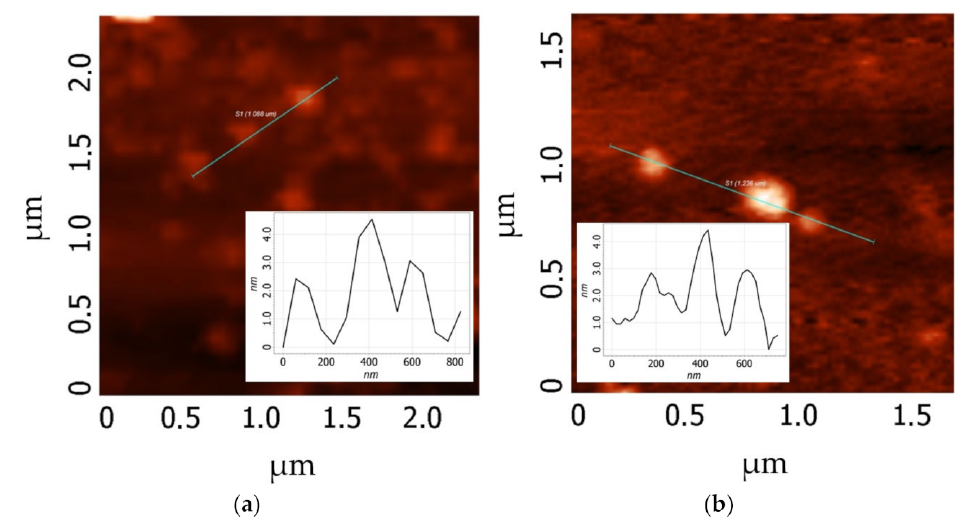
Figure 5. AFM images of individual flakes and their height profile: ( a ) GO; ( b ) MOG.